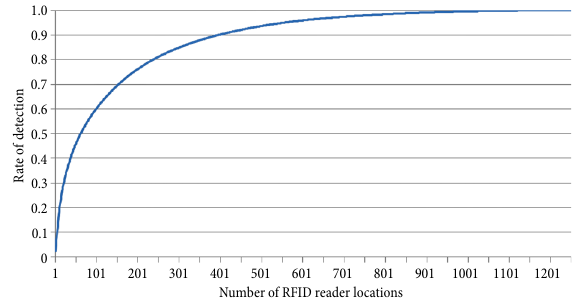
Fig. 3. Estimated link flows of the WND participants’ vehicles in Seoul